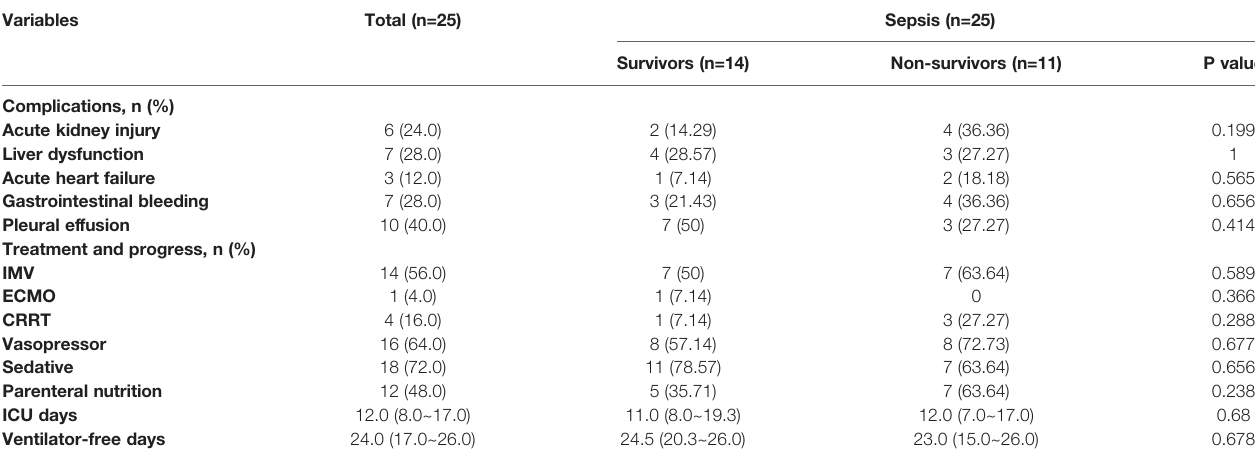
TABLE 3 | Complications and treatments of septic survivors and non-survivors.